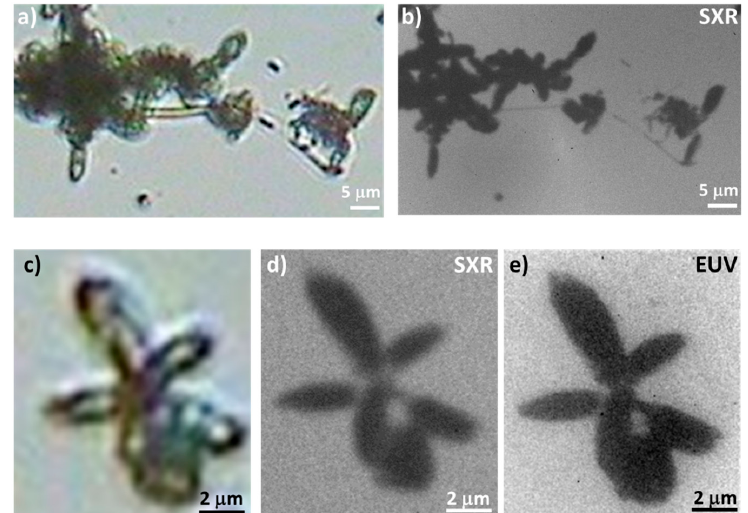
Figure 20. Direct comparison of Chrysodidymus synuroideus cells, imaged ( a ) with the optical microscope (visible light), ( b ) in the “water window” (acquired with 500 SXR pulses, 50 s exposure) and ( c ) in the EUV spectral range (acquired with 100 EUV pulses and 10 s exposure). ( c – e ) Show a direct comparison of a detail, imaged ( c ) with the visible light, ( d ) in the “water window” and ( e ) in the EUV spectral range